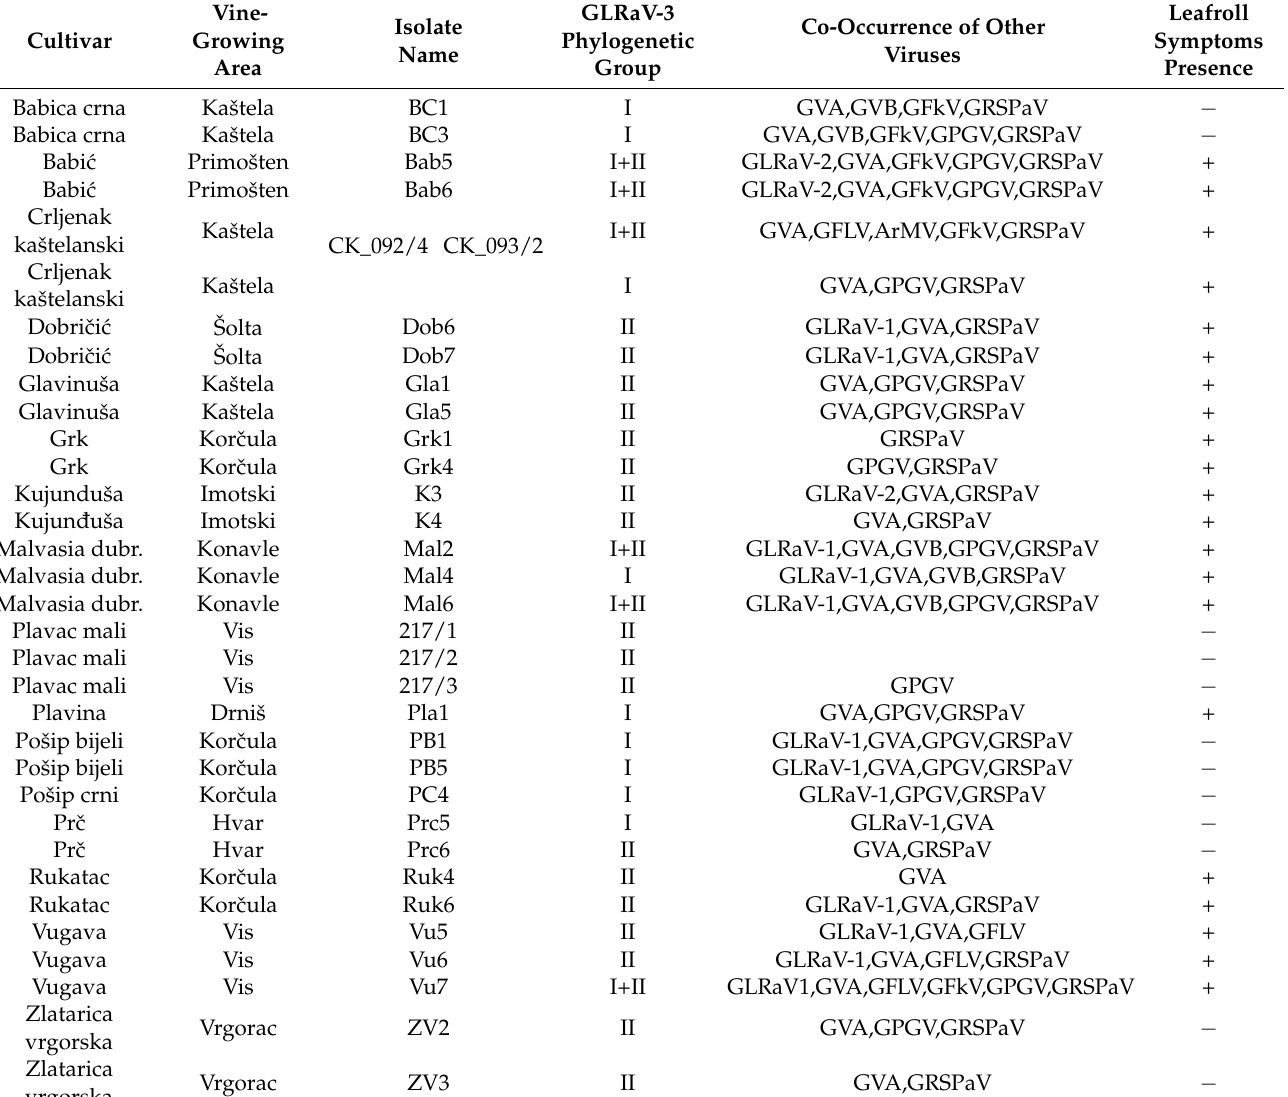
Table 1. The vine-growing area of grapevine cultivars, the genetic affiliation of GLRaV-3 isolates found, co-occurrence of other viruses, and the presence of leafroll disease